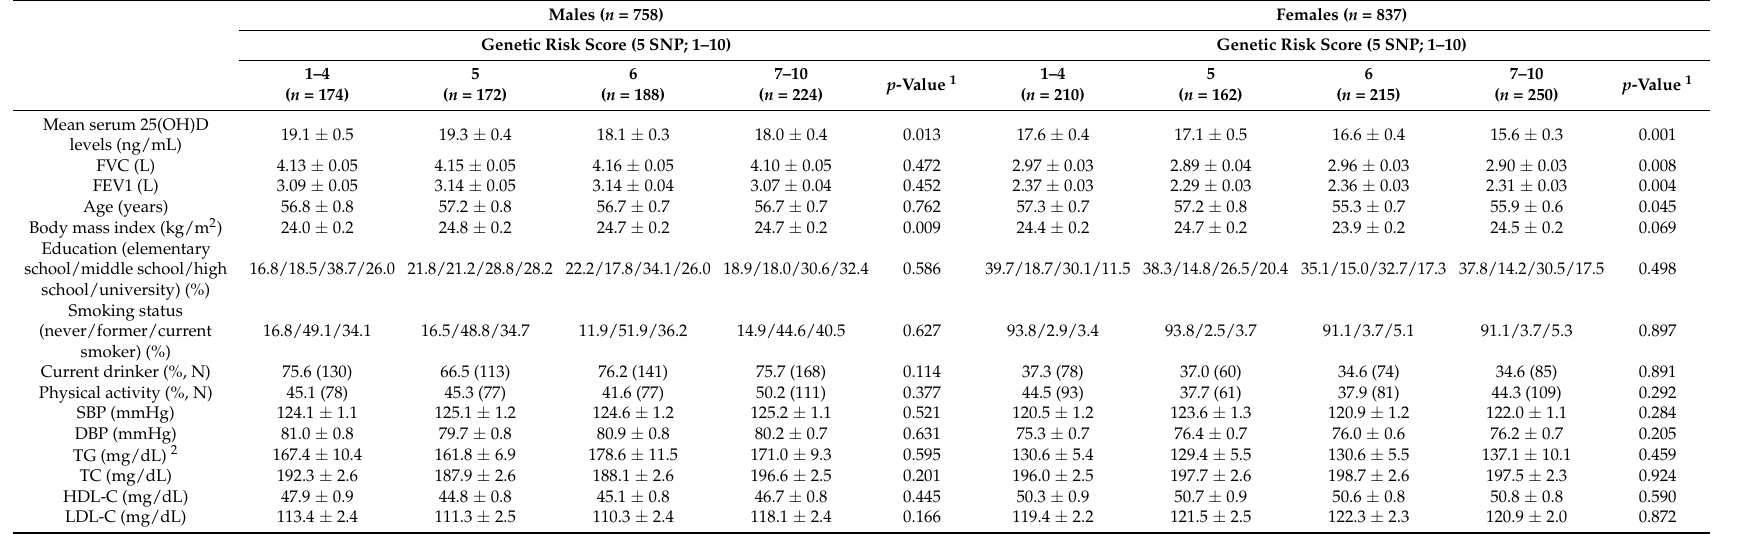
Table 2. Characteristics of study participants according to genetic risk score quartile and